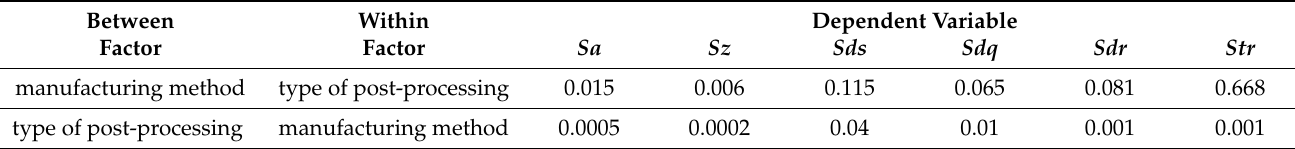
Figure 16. Developed interfacial area ratio Sdr of measured samples. Table 3. Probability values ( p -values) obtained as a result of repeated measures ANOVA examining the significance of the impact of the manufacturing method and type of post-processing treatment on surface topography